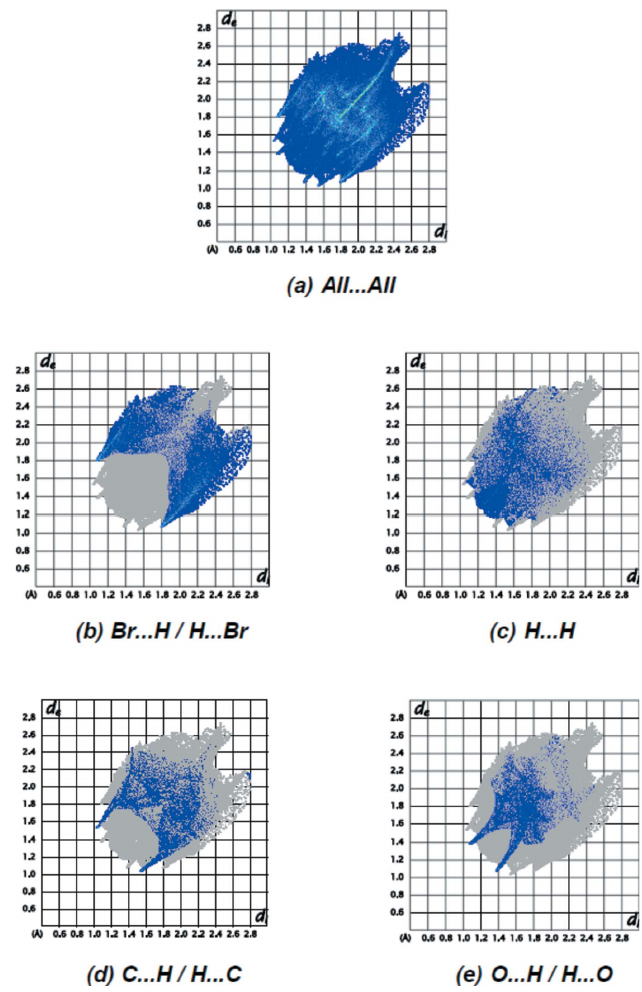
Figure 6 The full two-dimensional fingerprint plots for the title compound, showing ( a ) all interactions, and delineated into ( b ) Br (cid:2)(cid:2)(cid:2) H/H (cid:2)(cid:2)(cid:2) Br, ( c ) H (cid:2)(cid:2)(cid:2) H, ( d ) C (cid:2)(cid:2)(cid:2) H/H (cid:2)(cid:2)(cid:2) C, and ( e ) O (cid:2)(cid:2)(cid:2) H/H (cid:2)(cid:2)(cid:2) O interactions. The d i and d e values are the closest internal and external distances (in A˚ ) from given points on the Hirshfeld surface.